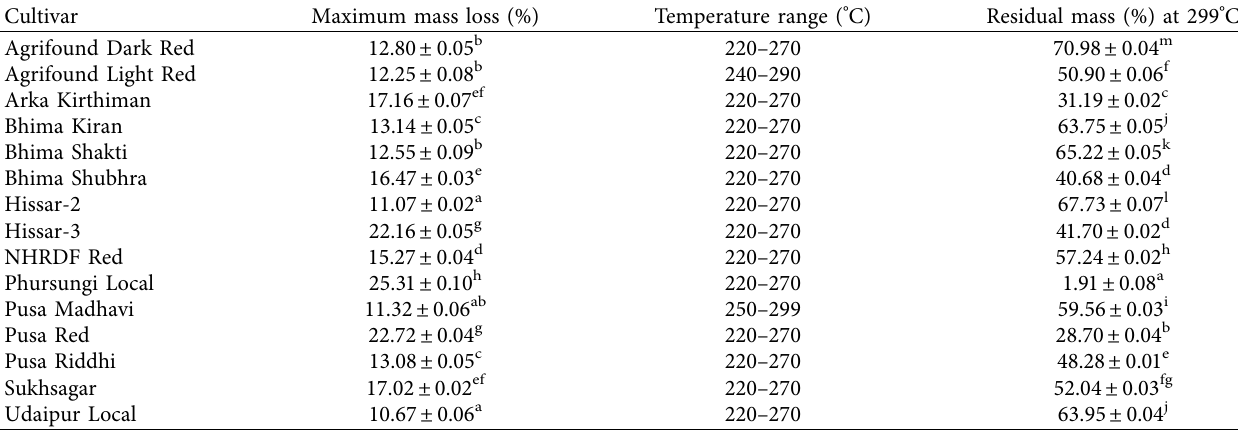
Data are mean value ± standard deviation ( n � 3). Values in the same column with different letters are significantly different ( P ≤ 0.05) by Duncan’s multiple range test.